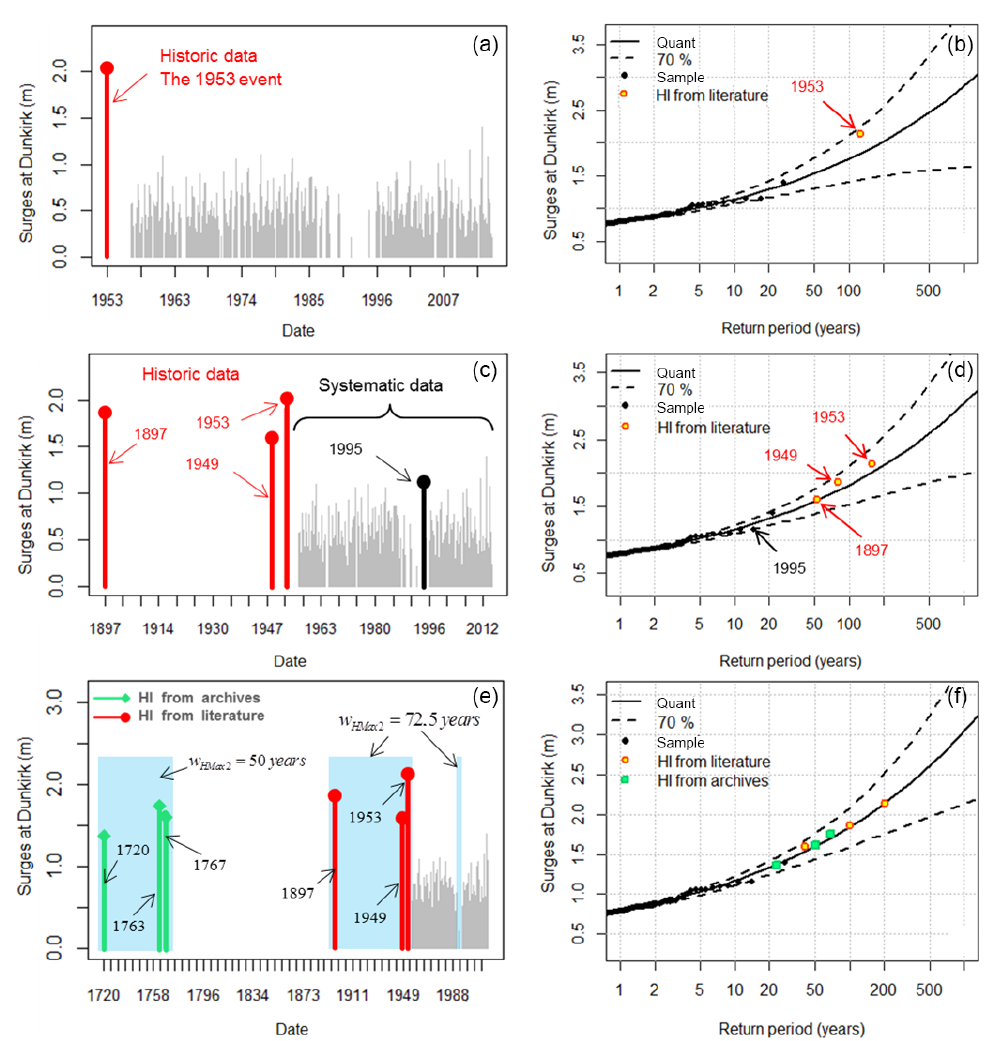
Figure 4. The GPD fitted to the POTH surges in Dunkirk: (a, b) the 1953 event as historical data; (c, d) with historical data from literature and (e, f) with historical data from literature and archives. The 1995 event is considered as